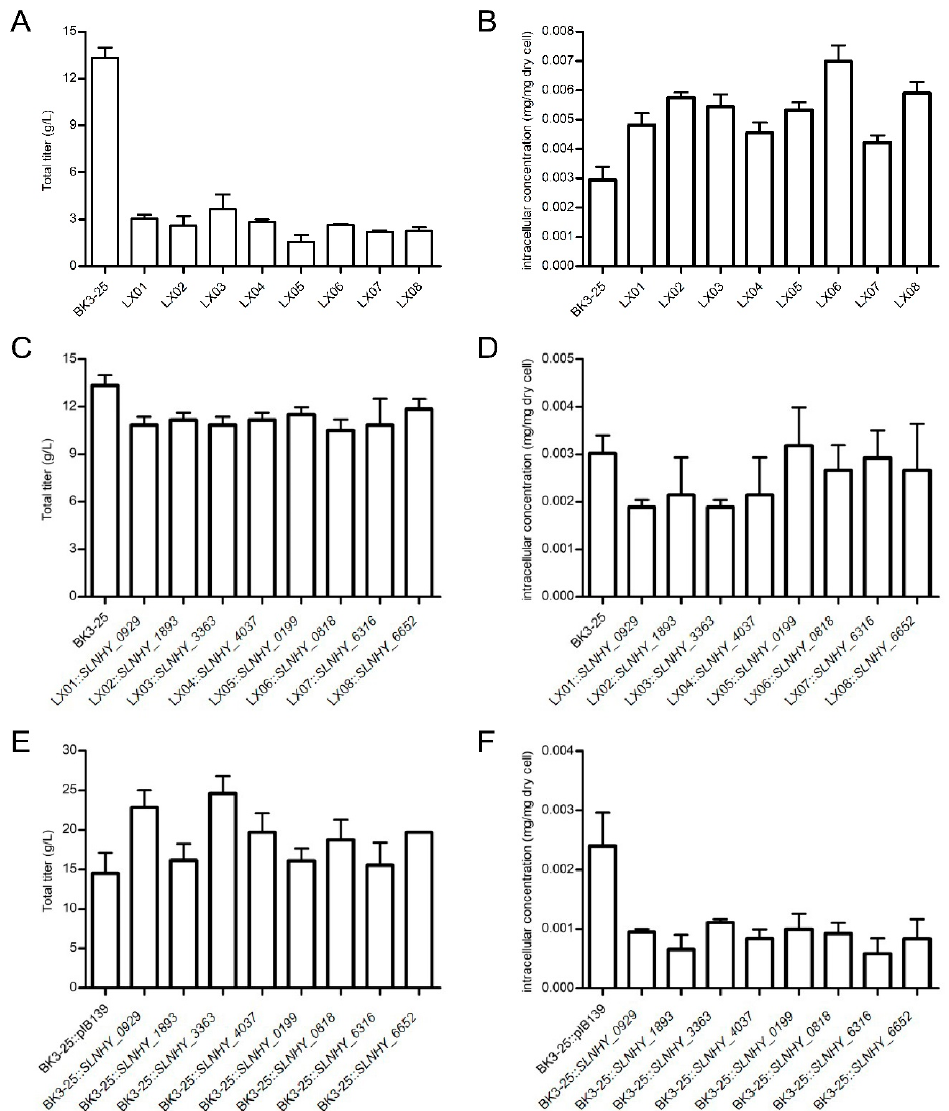
Figure 3. Salinomycin production of exporter gene mutants. ( A ) Total salinomycin titers of gene deletion mutants of BK3-25. ( B ) Intracellular salinomycin concentrations of gene deletion mutants. ( C ) Total salinomycin titers of gene complement mutants. ( D ) Intracellular salinomycin concentra- tions of gene complement mutants. ( E ) Total salinomycin titers of gene over-expression mutants. ( F ) Intracellular salinomycin concentrations of gene over-expression mutants. The total salinomycin titers were calculated based on the fermentation broth volume ( A , C , E ), and the intracellular salinomycin concentrations were calculated based on the dry cell weight ( B , D , F ). LX01, BK3-25 ∆ SLNHY_0929 ; LX02, BK3-25 ∆ SLNHY_1893 ; LX03, BK3-25 ∆ SLNHY_3363 ; LX04, BK3-25 ∆ SLNHY_4037 ; LX05, BK3-25 ∆ SLNHY_0199 ; LX06, BK3-25 ∆ SLNHY_0818 ; LX07, BK3- 25 ∆ SLNHY_6316 ; LX08, BK3-25 ∆ SLNHY_6652 PermE *. All individually complemented strains returned to 78.77–88.77% of the original